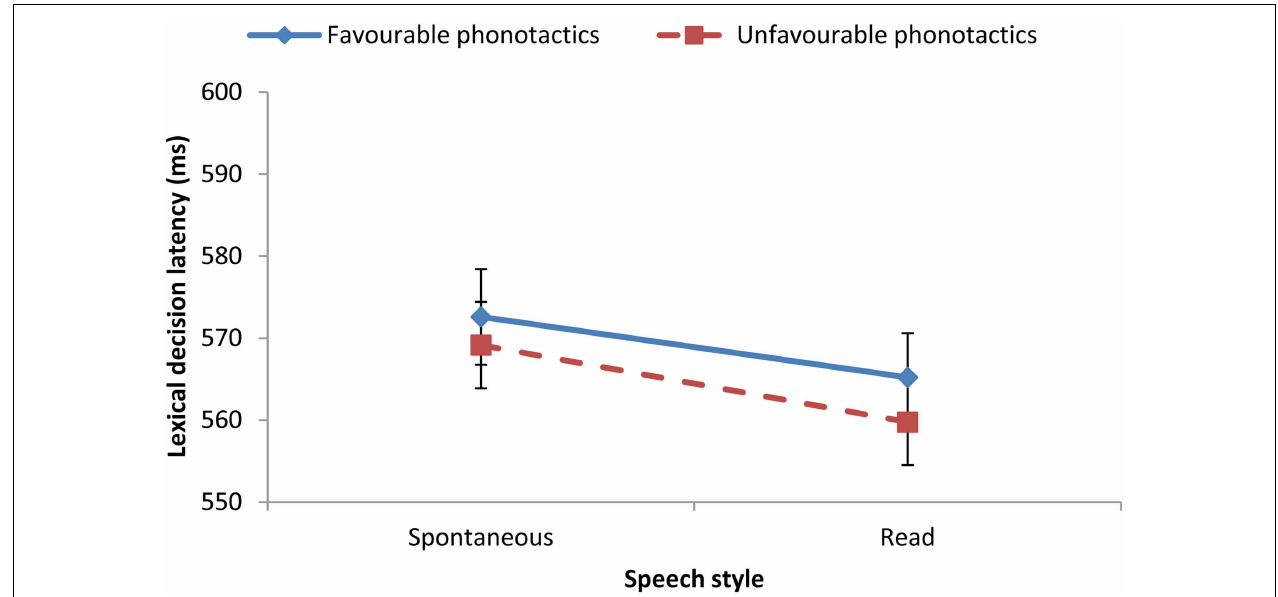
FIGURE 3 | Lexical-decision latencies (and standard errors) in the phonotactic segmentation condition for the two speech styles: spontaneous map dialogs vs. read sentences (117 participants). Favorable